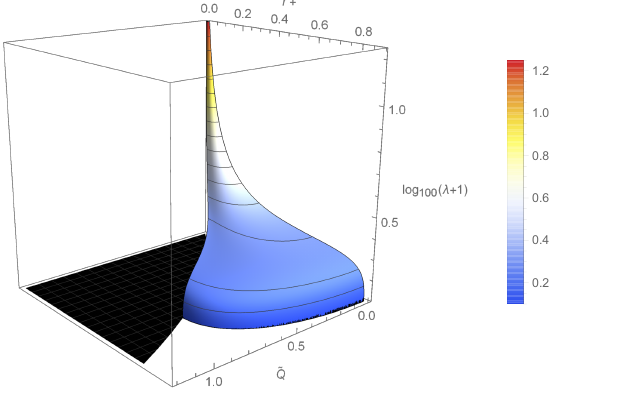
Figure 6 . Three-dimensional plot of log ( λ + 1) as a function of ˜ Q and ˜ r + for massive particles 100 with L = 20 l . There is no black hole solution in the black region, and black holes in the white region have no unstable time-like circular